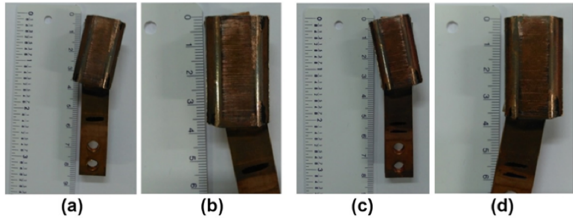
Figure 8. Sample 1: ( a ) whole body, ( b ) measurement region; Sample 2: ( c ) whole body, ( d ) measurement region.